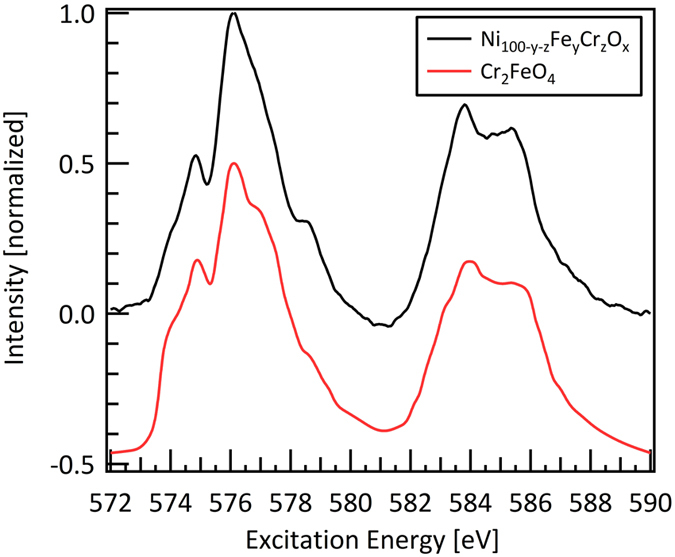
Cr L3- and Cr L2-edge of Ni1-y-zFeyCrzOx.No variation of the Cr L-edges is observed across the entire materials library. The reference spectrum of Cr2FeO4 is adopted from23 and shifted downwards by 0.5 for better readability.